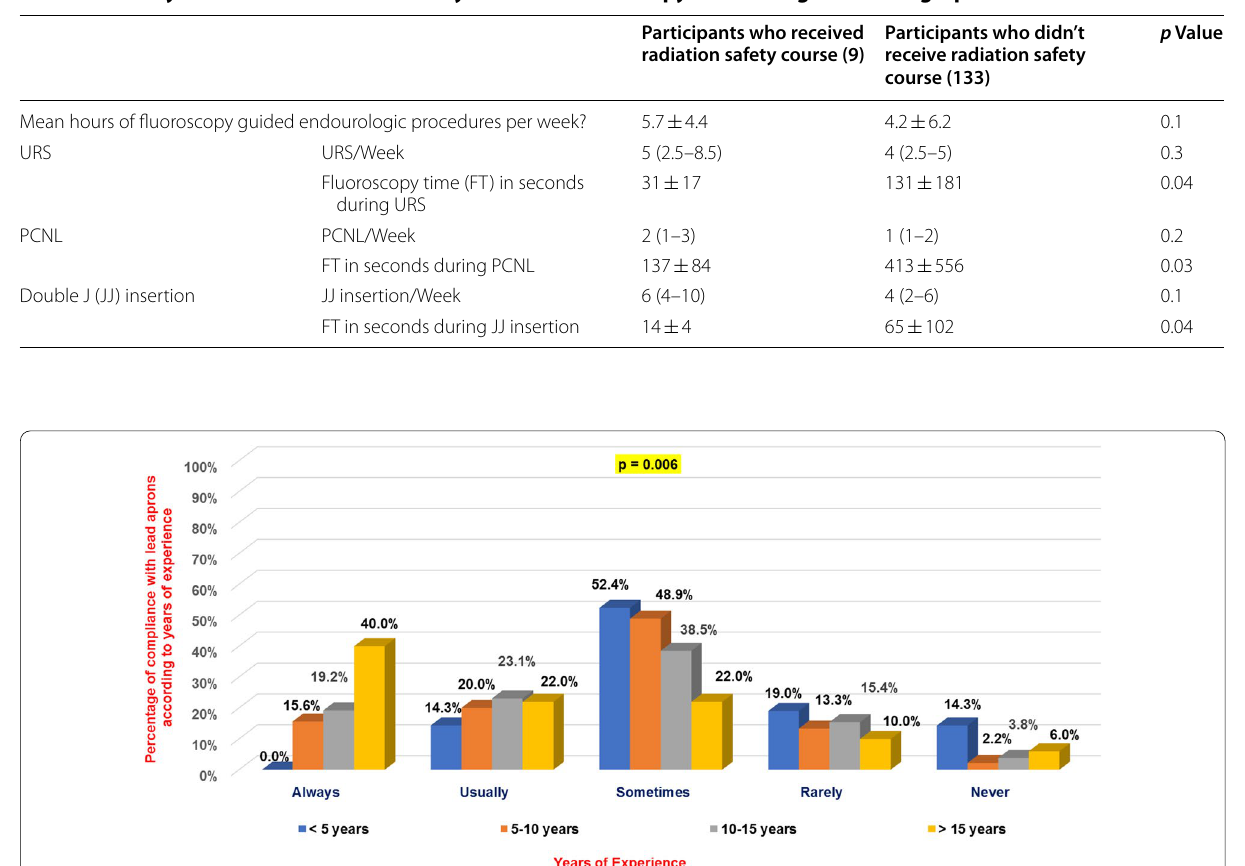
Table 2 Comparison between participants who received radiation safety course and participants who did not receive radiation safety course in terms of the ability to reduce fluoroscopy time during Endourologic procedures